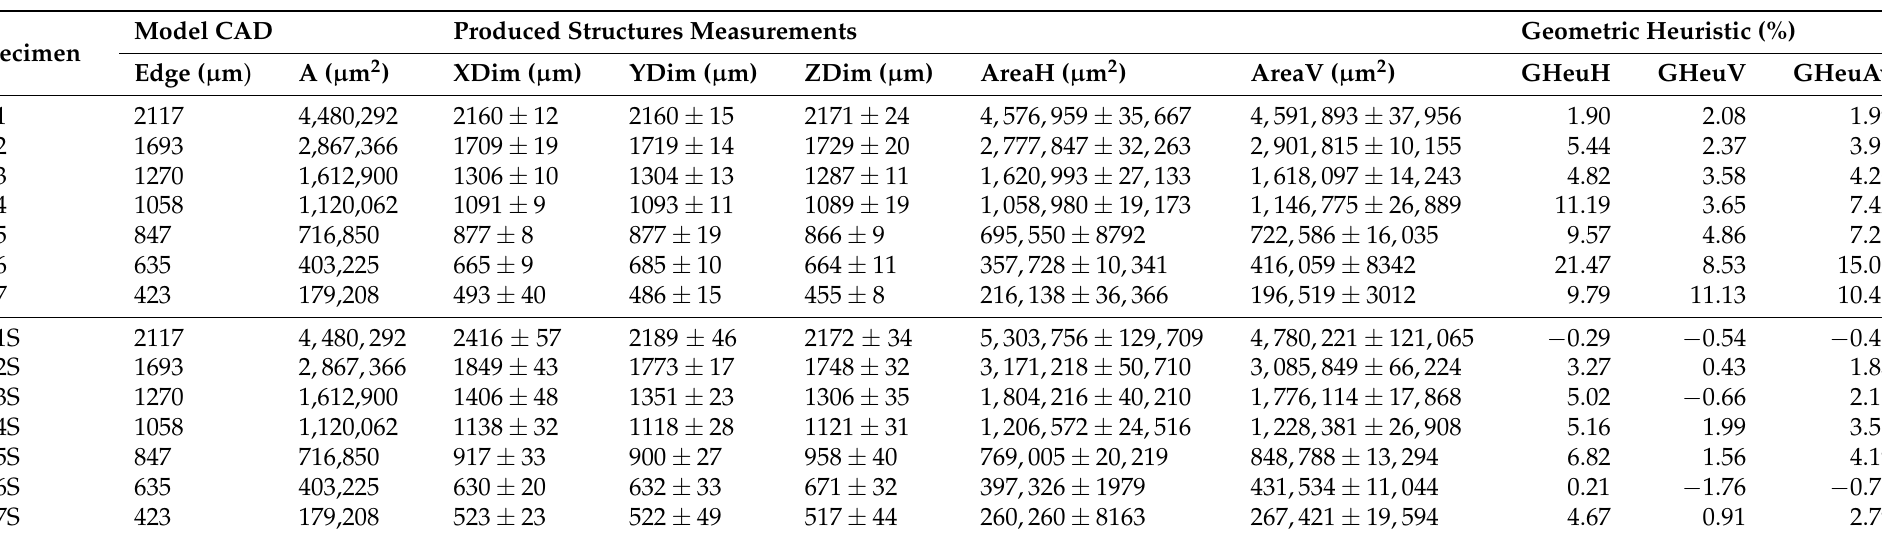
Table 3. Comparison between the CAD model (nominal) and the produced cubes’